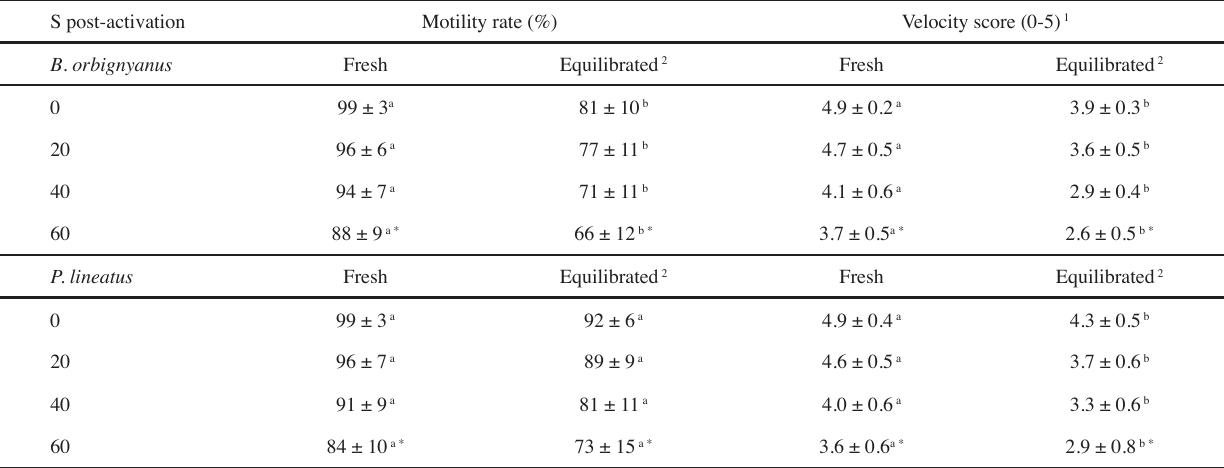
Table 2. Motility rate and motility velocity score (mean ± SD) of fresh and equilibrated sperm of Brycon orbignyanus ( n = 18 males) and Prochilodus lineatus ( n = 21 males) evaluated after 0, 20, 40 and 60s of activation. S post-activation Motility rate (%) Velocity score (0-5) 1